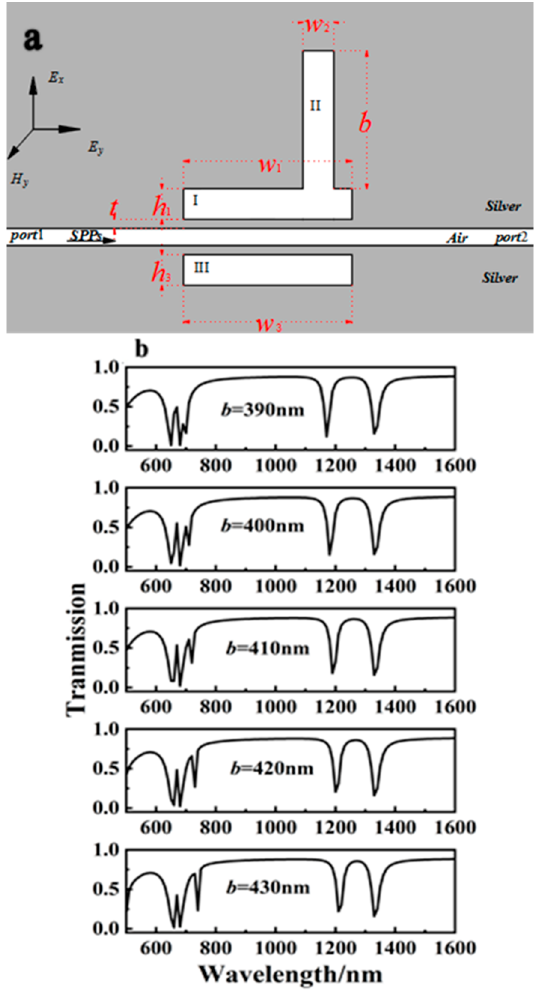
Figure 11. ( a ) Structure diagram of a MIM with three rectangular resonators after cavities I and II were partially combined and w 1 = w 3 = 500 nm. ( b ) Off-to-on transmission spectra of the three-rectangle-resonator PIT system.